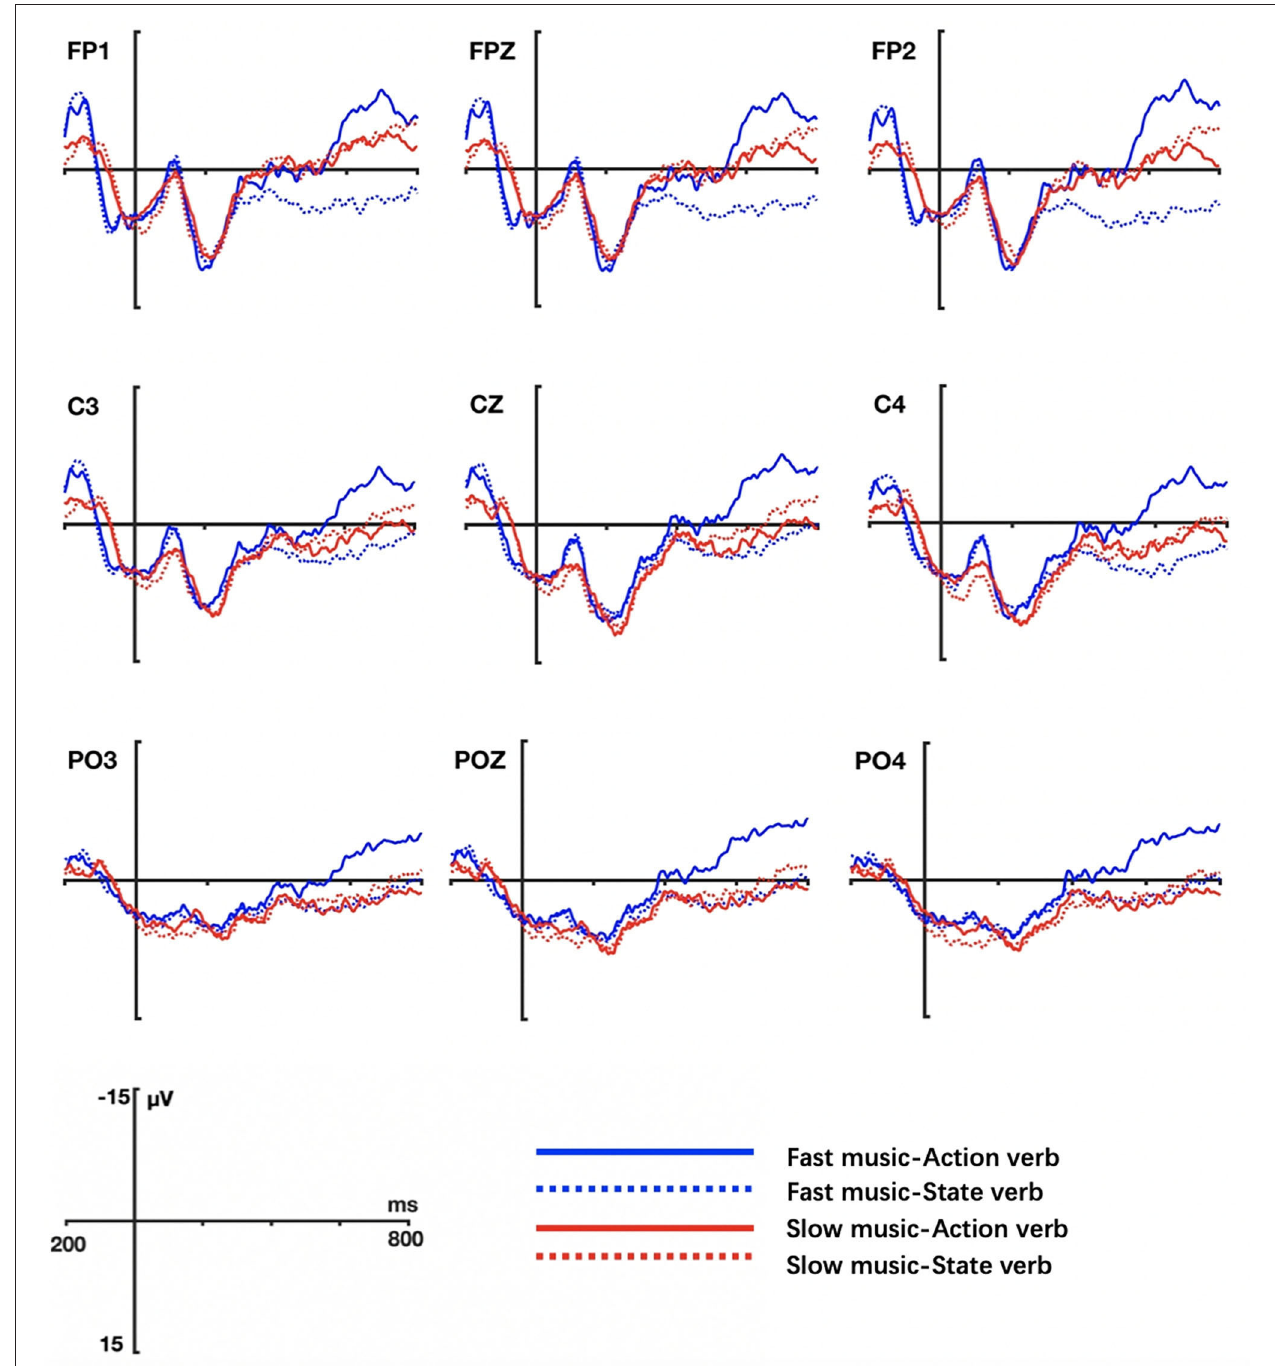
FIGURE 4 | Grand ERP averages elicited by action and state verbs in tempo-without-change music priming conditions (Task 2).